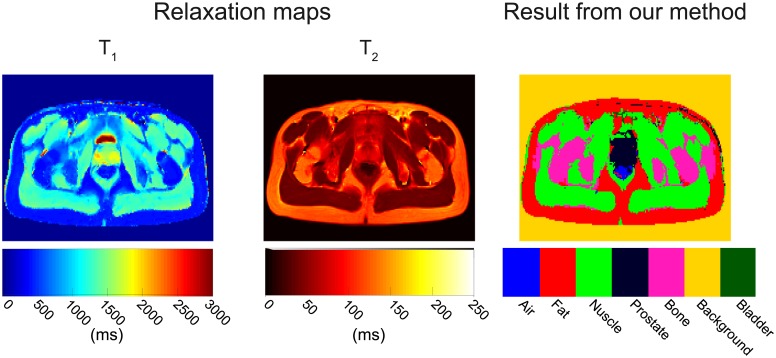
Relaxation maps and segmentation map of volunteer 1.Both T1 and T2 relaxations maps show homogeneous time values within the area of each tissue: prostate, muscle, fat, bladder and bone marrow. In the T1 and T2 maps, fat and bone marrow are not visually separable. The same happens in the T2 map for prostate and fat, muscle and bladder. However, the SVM classifier accuracy is rather excellent for prostate = 99.6%, fat = 92.5%, muscle = 99.3%, and bone marrow = 96.7%. Accuracy is lower for bladder (10.4%) and air (45%) mostly because of the small size of these regions.